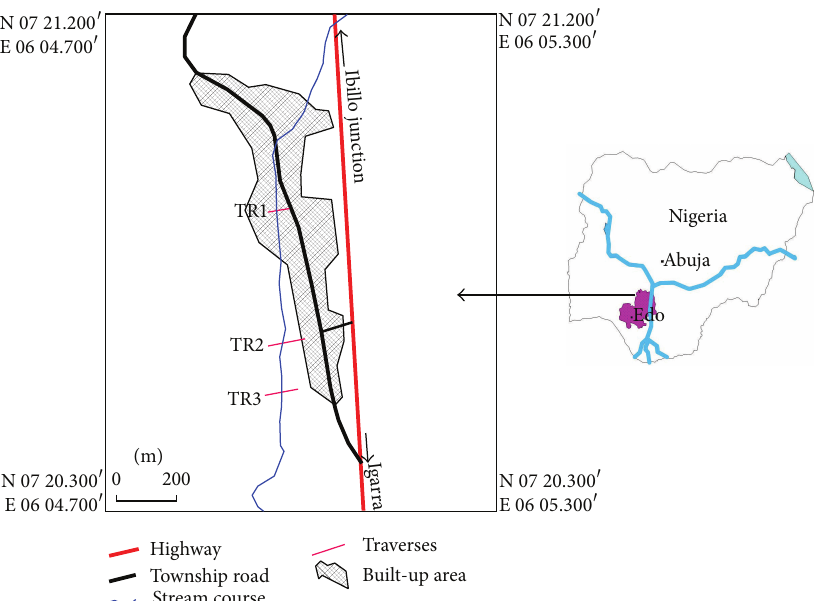
Figure 1: Composite map of study location. Uneme-Nekhua is an elongate settlement parallel to the Ibillo-Igarra highway. The built-up area generally takes advantage of a ridge structure, while the stream course follows in the adjacent valley west of the ridge.